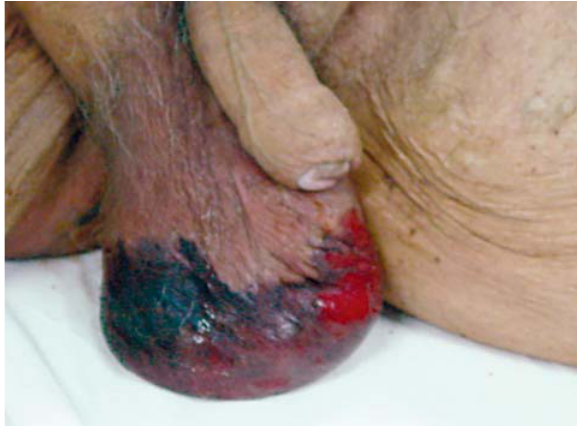
Table 1 – Distribution of the 67 patients divided in